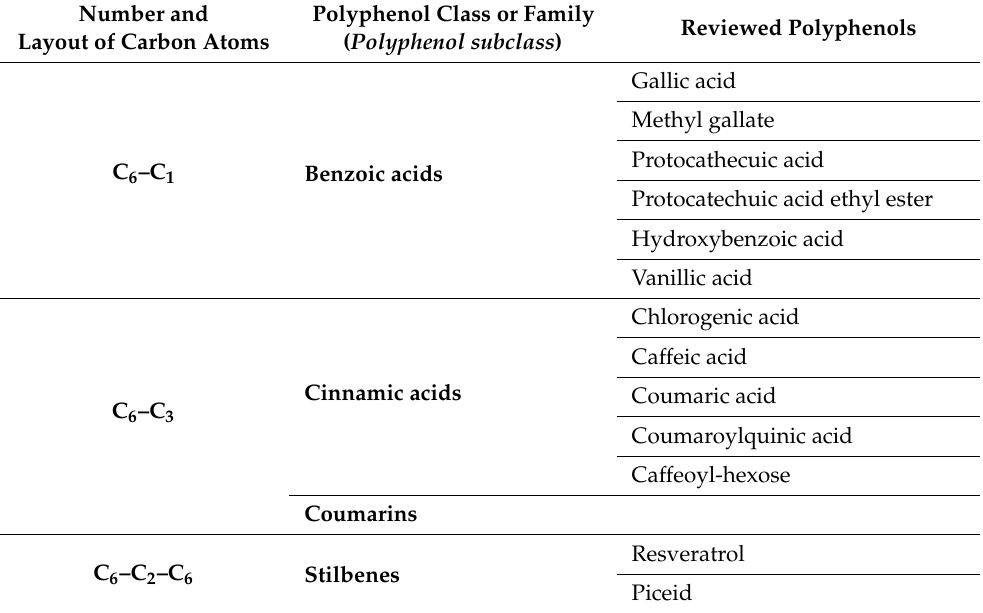
Table 1. Classification of the main active polyphenols against clinical isolates reviewed. Number